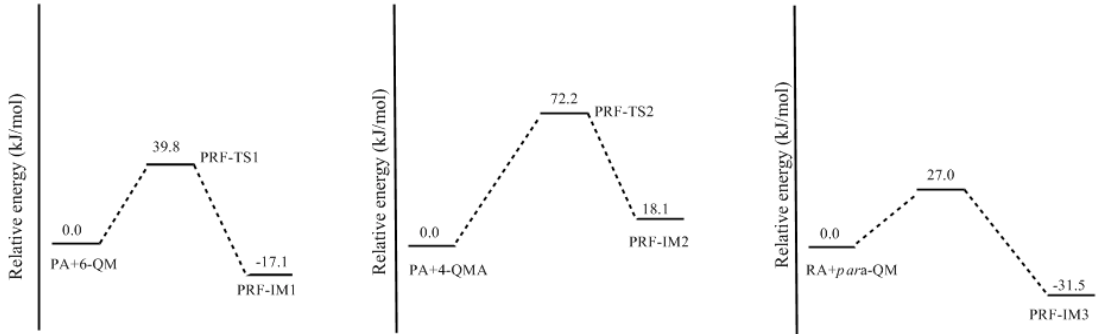
Figure 15. The potential energy profiles for the Michael addition reactions in Figure 13.